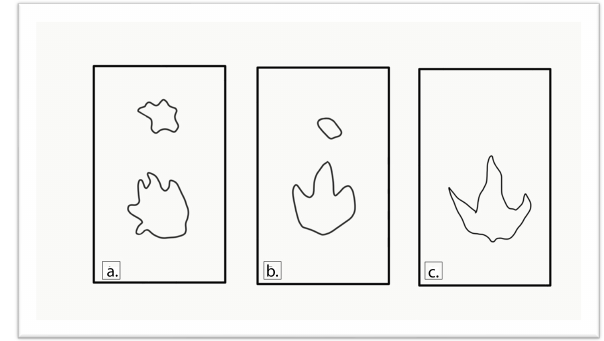
Figure 2. The general shapes of the three types of Cretaceous di- nosaur footprints identified (Kappus and Cornell, 2003; Kappus et al., 2011; Martinez, 2016) at Cristo Rey. Panel (a) is an ankylosaur, panel (b) is an iguanodon, and panel (c) is a theropod (outlines mod- ified from Kappus et al.,